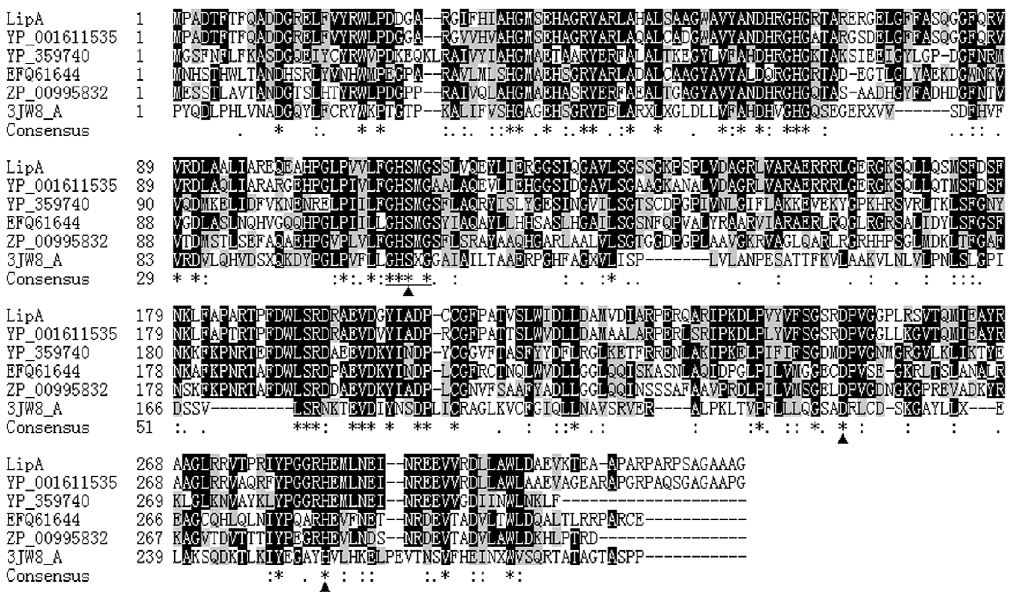
Figure 1. Multiple sequence alignment of LipA and other related proteins. Sequences